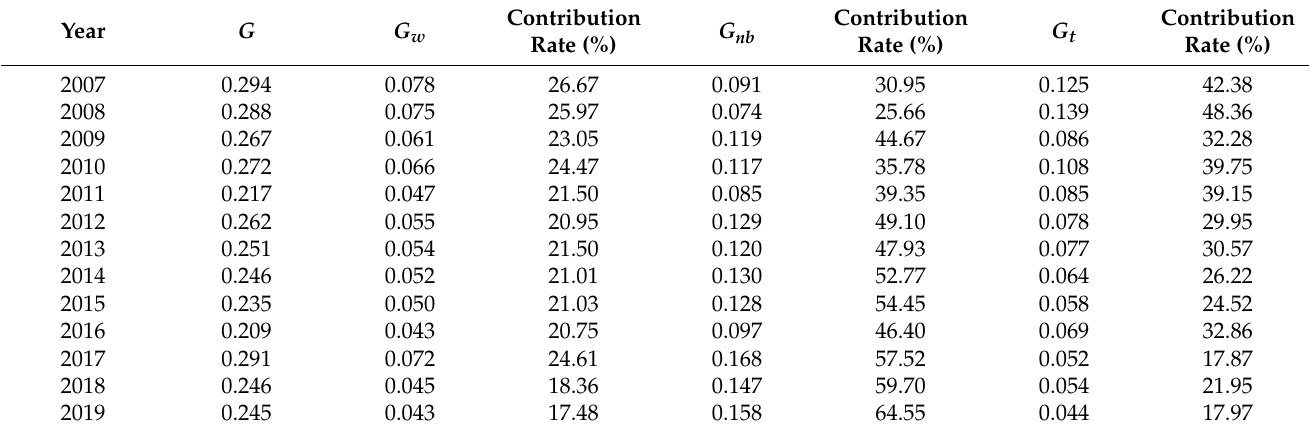
Table 5. Spatial differences decomposition of EWP in the Poyang Lake area from 2007 to 2019.